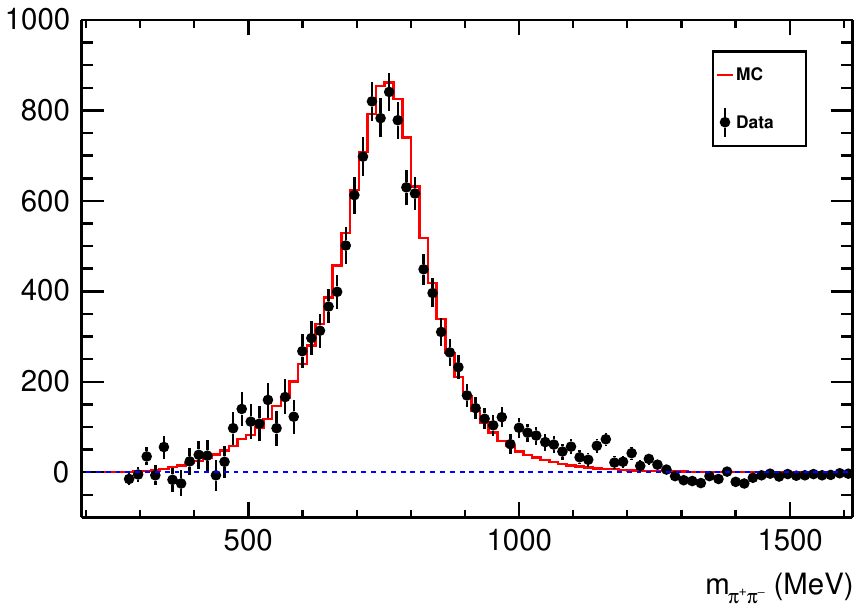
p s = 1 : 3{1 : 8 GeV. The